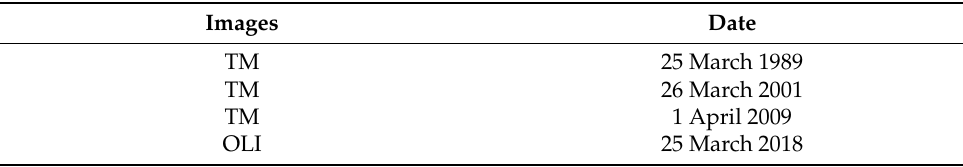
Table 1. Landsat image acquisition and date.